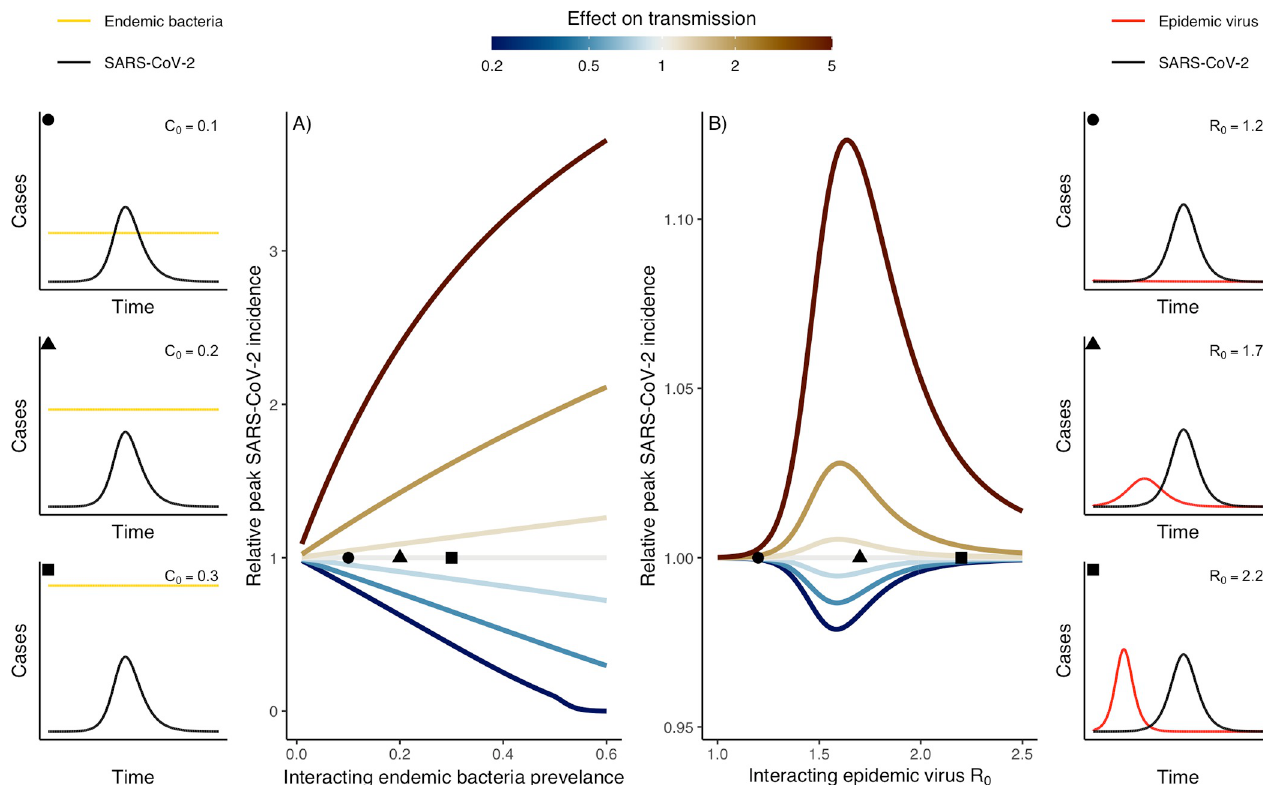
Fig 5. Predicted impact of interaction on SARS-CoV-2 dynamics from mathematical models of SARS-CoV-2 interaction. Panel A: Interaction with colonizing bacteria (e.g., Streptococcus pneumoniae ). Panel B: Interaction with a seasonal virus (e.g., influenza A virus). Insets represent three example simulations for each of the two models, varying the prevalence of bacterial colonization ( C 0 ) and the basic reproduction number ( R 0 ) of the interacting virus (the circle, triangle, and square symbols indicate the corresponding parameter values in the main figures). Note, the vertical axes are on different scales, showing the more pronounced impact of interactions with endemic colonizing bacteria. The data presented are primary data, generated from illustrative models designed for the purpose of this review; full model details are included in S1 Appendix.